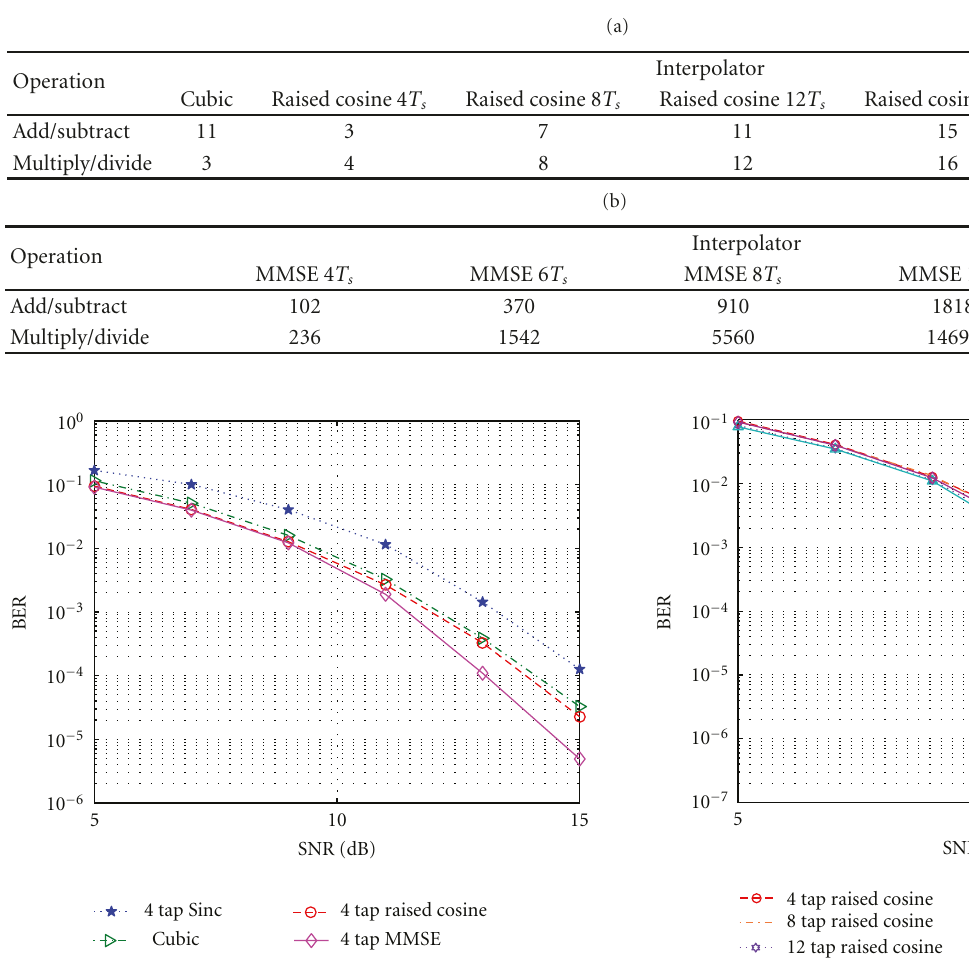
Table 1: Computational complexities with require computing an interpolant.